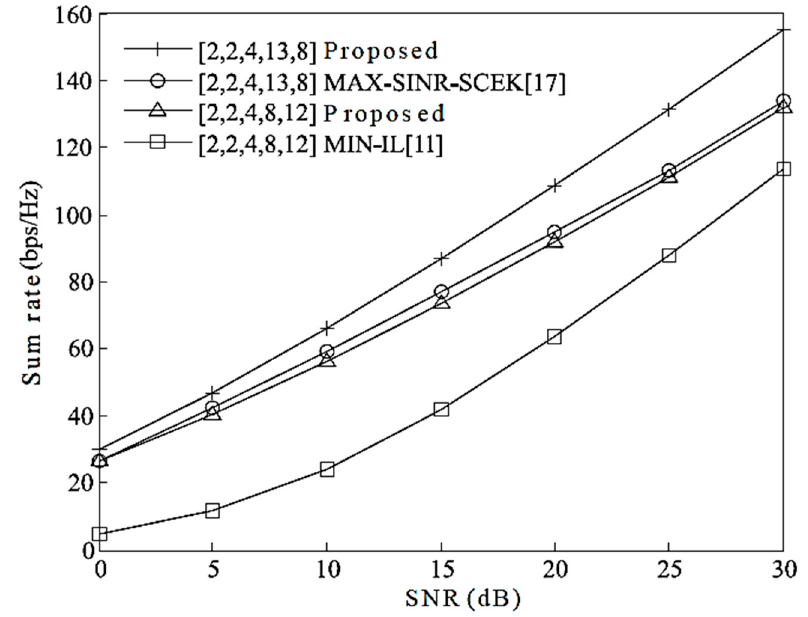
Figure 2. The average system capacity comparison under the ideal CSI.